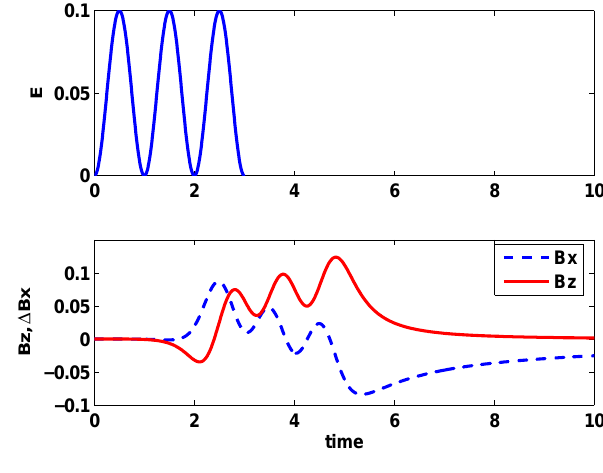
Fig. 2. Triple reconnection pulse and the corresponding magnetic field